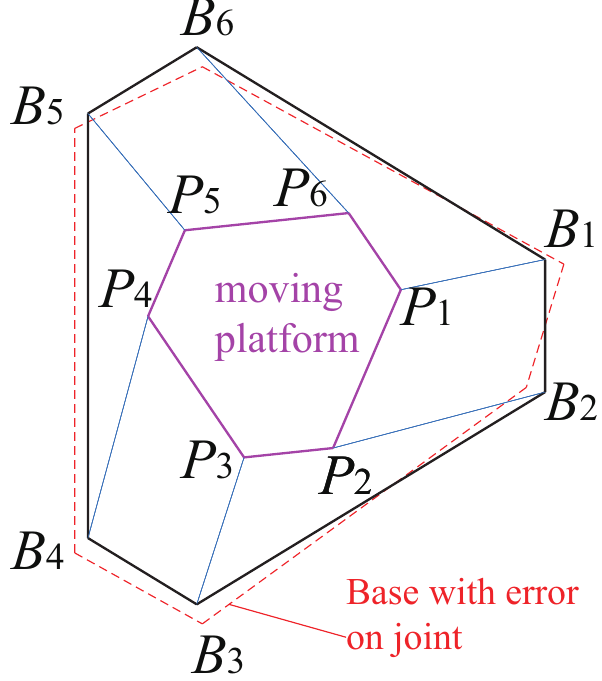
Figure 11. Gough–Stewart platform optimized using LineBVS [Case